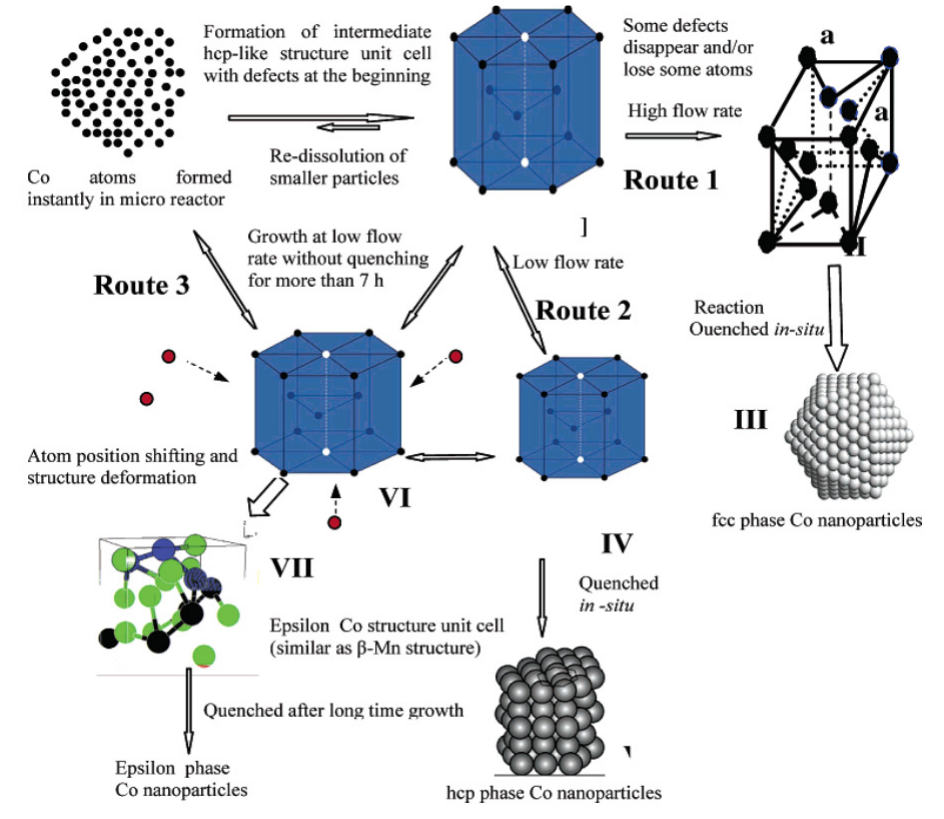
Figure 18. Proposed formation route for the different phases of Co nanoparticles [29].